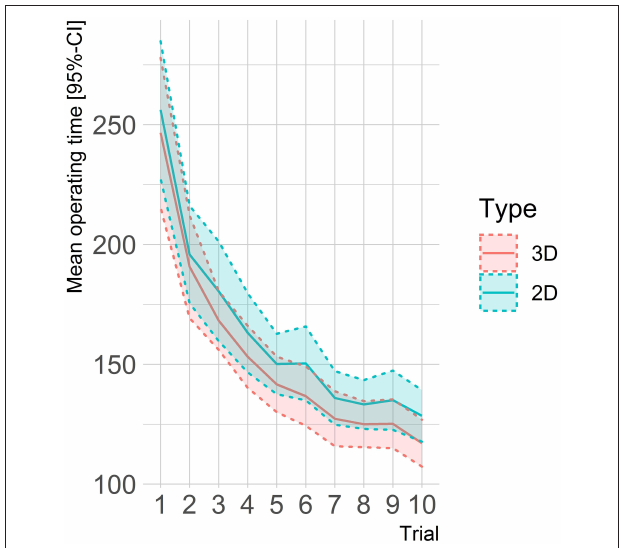
FIGURE 2 | Mean operating time and 95% confidence